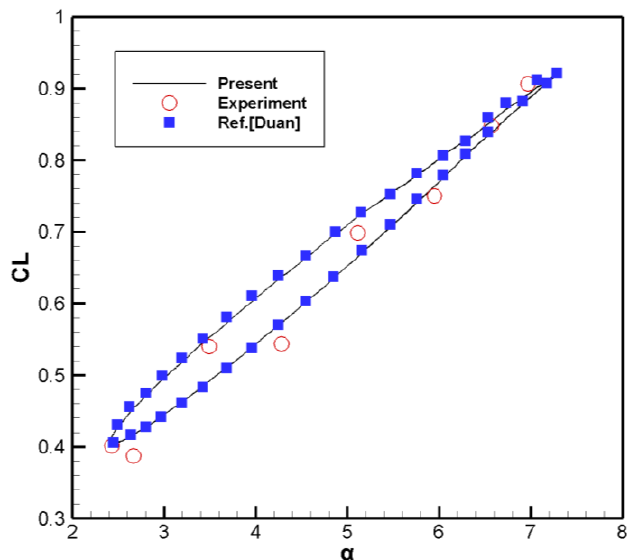
Figure 5. Lift coefficients varying with attack angle.